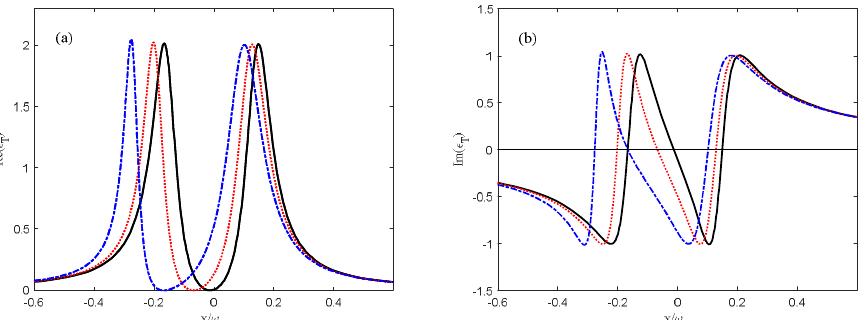
Figure 3. The output probe field amplitude ε T as a function of normalized detuning x / ω m for different mechanical nonlinearity strength α . ( a ) Absorption spectrum. ( b ) Dispersion spectrum. Black solid line, red dotted line and blue dashed line represent the mechanical nonlinearity strength α = 0, α = 5 × 10 7 N/m 2 , and α = 12 × 10 7 N/m 2 ,